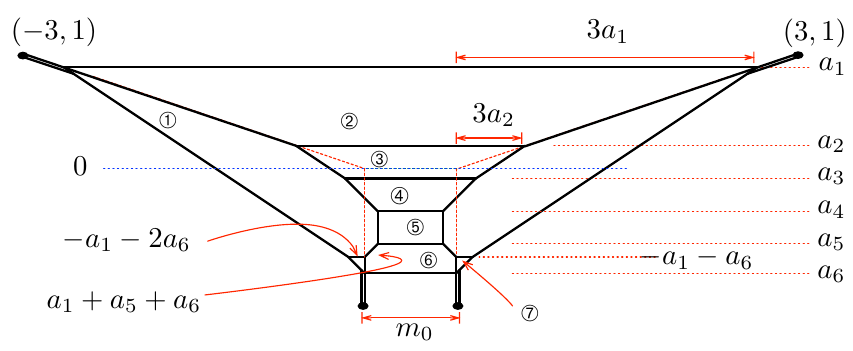
Figure 1 . A 5-brane web for SU(6) 3 theory with one massless hypermultiplet in the rank-3 anti- symmetric